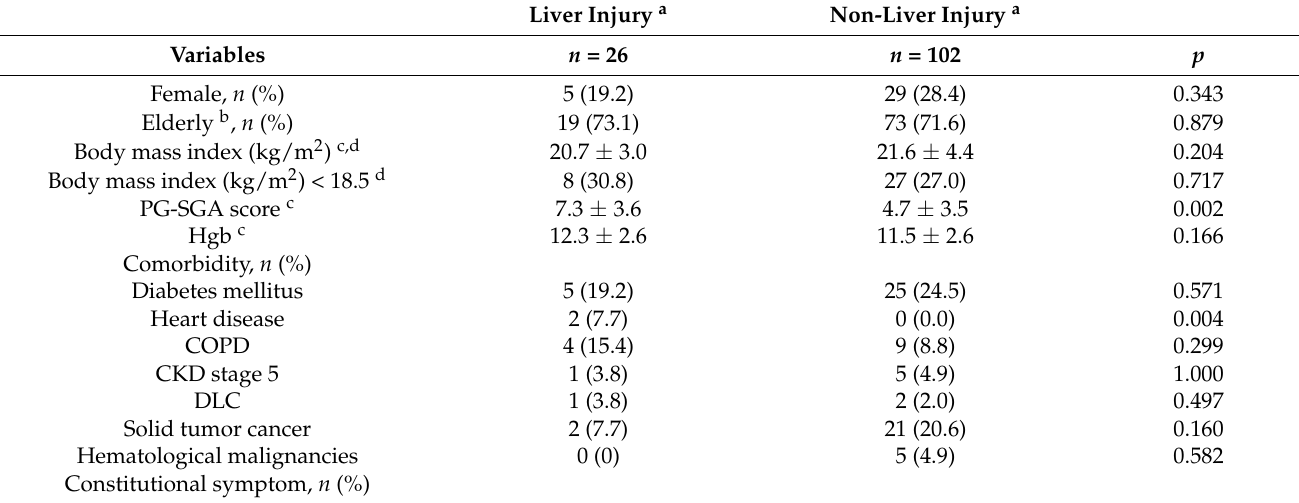
Table 2. Risk factors for liver injury during